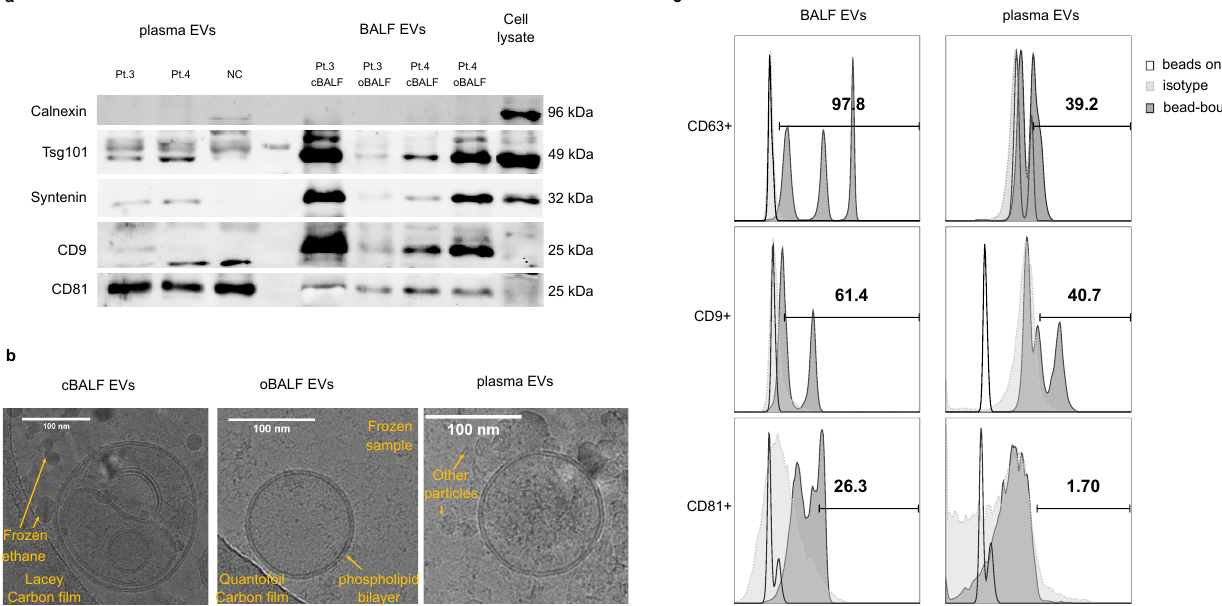
Figure 2. Characterization of plasma/BAL EVs from NSCLC patients. ( a ) Immunoblot analysis of EVs from plasma and BALF of two NSCLC patients (Pt.3, Pt.4), a normal donor (NC), and a cell lysate. The loaded EV amounts correspond to 100 µ L of the patients’ plasma or 4 mL of the patients’ BALF, respectively. As a control, 10 µ g of a cell lysate from the SEMK2 cell line was loaded. Full blots from ( a , b ) are provided in the Supplementary Materials. ( b ) Cryo-TEM imaging of EVs from cBALF, oBALF, and plasma from a NSCLC patient. ( c ) Flow cytometry of EVs from BALF and plasma attached to a mix of anti-CD63, anti-CD9, and anti-CD81 magnetic beads and then labeled with fluorescent anti-CD63, anti-CD9, and anti-C81 antibodies,